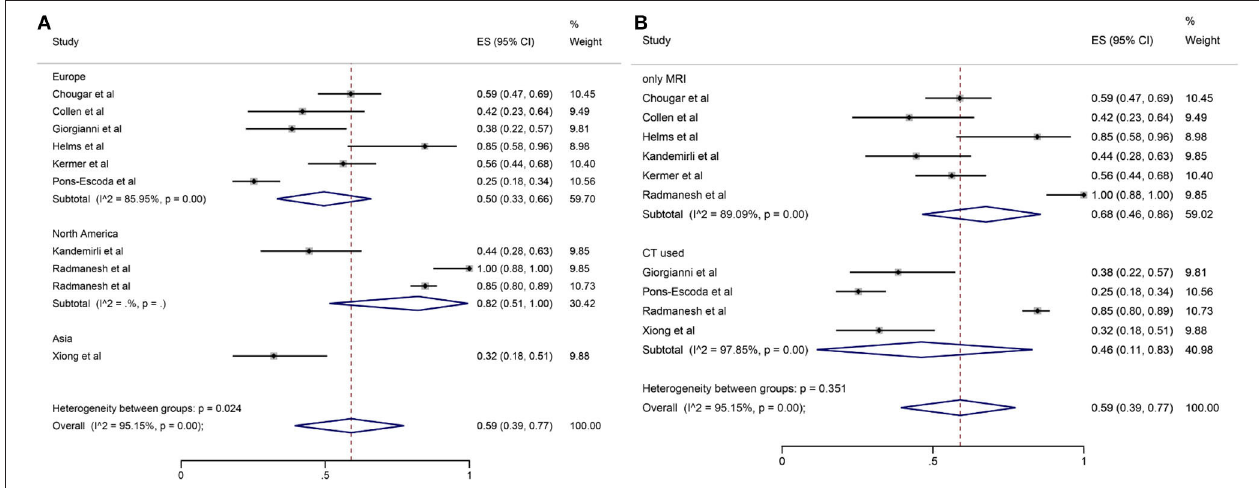
FIGURE 3 | Forest plot for subgroup analysis by (A) continent; (B) neuroimaging tool regarding the proportion of abnormal neuroimaging finding.